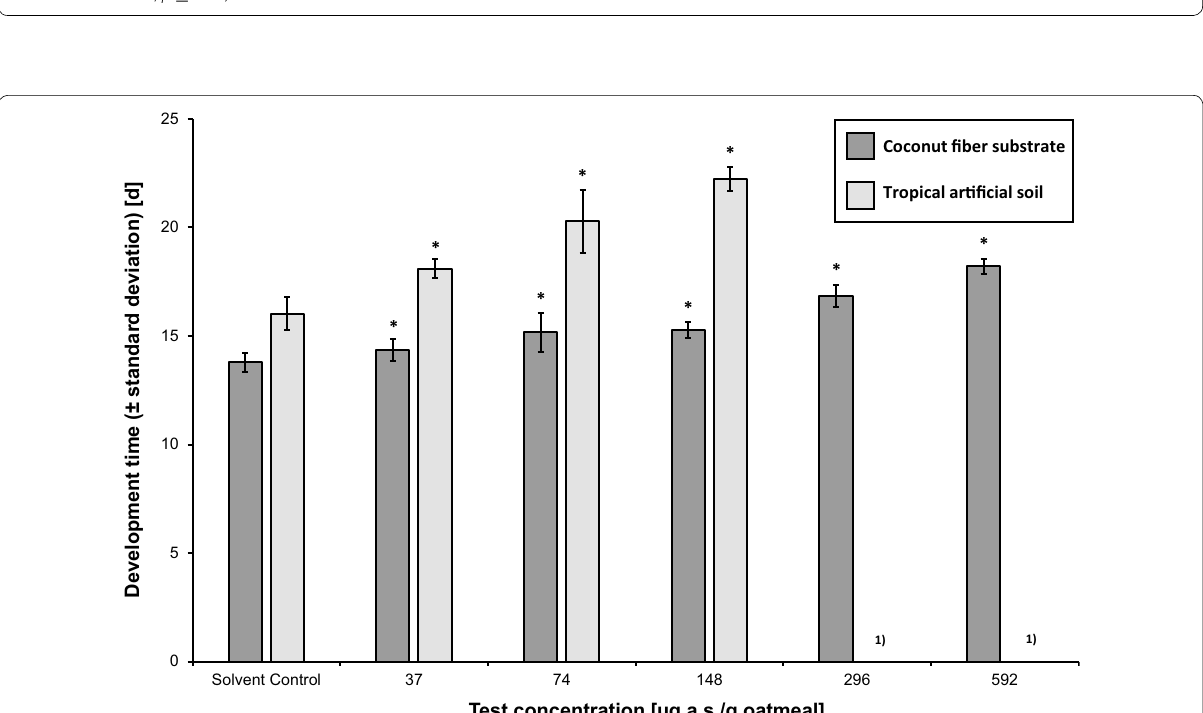
Fig. 5 Effect of neem oil (a.s. azadirachtin)-spiked oatmeal in coconut fiber substrate and tropical artificial soil at 20 °C on the development time ( standard deviation) [d] of Bradysia impatiens . *Significant difference between treatment and solvent control (Williams t test, one-sided greater, ± p 0.05). a.s. active substance. 1) No ≤